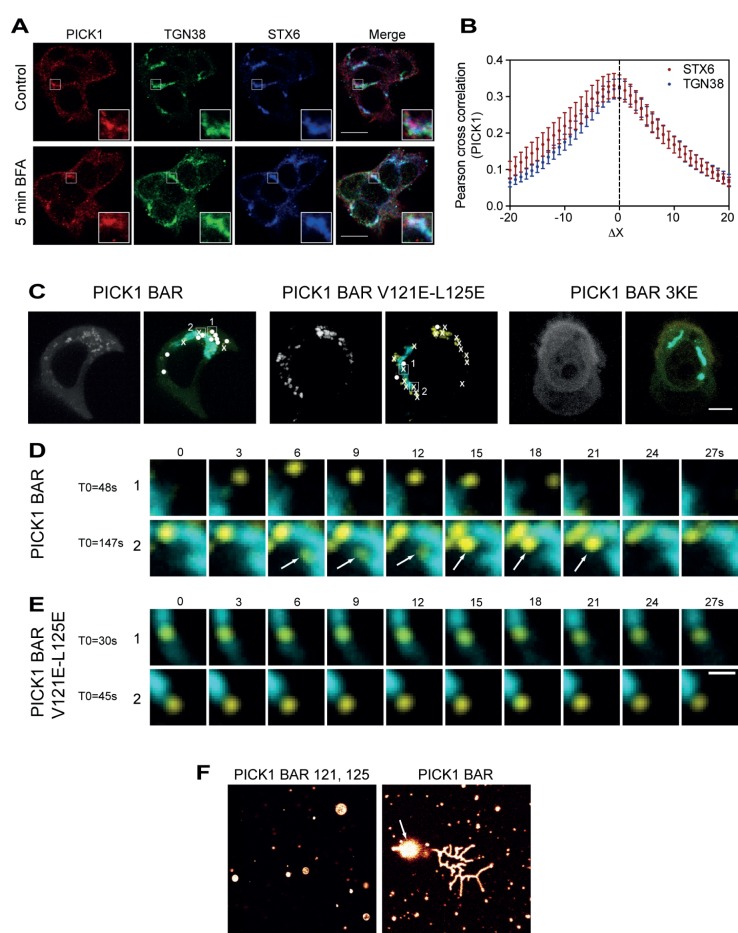
PICK1 associates transiently with the Golgi compartment and is capable of tubular deformation of liposomes in vitro.(A) Brief (5 min) brefeldin A treatment traps PICK1 in the trans-Golgi. Confocal images of GH1 cells immunostained for PICK1, and the trans-Golgi marker TGN38, and the trans-Golgi/immature vesicle marker syntaxin 6 before (top) and after 5 min BFA treatment (bottom). Panels show from left signal from immunolabeled PICK1 (Alexa Fluor 568 signal), signal from TGN38 (Alexa Fluor 488 signal), signal from syntaxin 6 (Alexa Fluor 647 signal), and overlay of the three channels. Insets highlight an area with overlapping localization of PICK1 and syntaxin 6 but with PICK1 adjacent to TGN38 (top) and colocalization of PICK1 with both syntaxin and TGN38 (bottom). (B) Quantification of the PICK1 colocalization with TGN38 and syntaxin 6 after 5 min BFA treatment using Van Steensel's cross-correlation function, which reports the Pearson cross-correlation as a function of the relative movement of the two channels with respect to each other. Both syntaxin 6 and TGN38 show a sharp peak of similar height close to Δx = 0, indicating specific co-localization. Co-localization was quantified for 10–20 cells from three independent experiments, and data are means ± SE. Note that the drop in peak values compared to no BFA (Figure 6F) likely reflects the increased diffuse localization of both markers after BFA treatment. (C) Fast time-lapse dual color live confocal imaging showing transient association of YFP-PICK1 BAR with the Golgi marker GalT-Cerulean. Images are maximal intensity projections of representative time-lapse series for YFP-PICK1 BAR (left), YFP PICK1 BAR V121E-L125E (middle), and YFP-PICK1 BAR 3KE (right). The gray scale projections (left images) show the YFP channel alone, indicating highly dynamic behavior of YFP PICK1 BAR (left) and more static behaviour of YFP-PICK1 BAR V121E-L125E (middle) punctae, whereas no punctae are seen for YFP-PICK1 BAR 3KE (right). The dual color projections (right images, YFP channel in yellow, Cerulean channel in blue) show that most of the activity for YFP-PICK BAR (left) is lining the Golgi, whereas YFP-PICK1 BAR V121E-L125E (middle) shows activity throughout the cell. Circles indicate transiently appearing punctate structures (lasting for less than 10 frames, ∼30 s). Crosses indicate stable punctate structures lasting for more than 10 frames. (D) Time-lapse series of two transient punctate structures of YFP-PICK1 BAR, and (E) two stable punctate structures of YFP-PICK1 BAR V121E-L125E. Scale bar, large images 5 µm, time lapse 1 µm. (F) Tubulation of surface-immobilized artificial giant membrane vesicles by the PICK1 BAR domain. Purified and Alexa Fluor 488–labeled GST-PICK1 BAR or GST-PICK1 BAR V121E-L125E (control) with impaired membrane binding capacity. Protein was incubated at room temperature with surface immobilized and fluorescently labeled vesicles before confocal fluorescent imaging. No effect was seen for the mutant, whereas massive tubulation was seen with GST-PICK1 BAR. Arrow indicates a budding vesicle from a single GV.